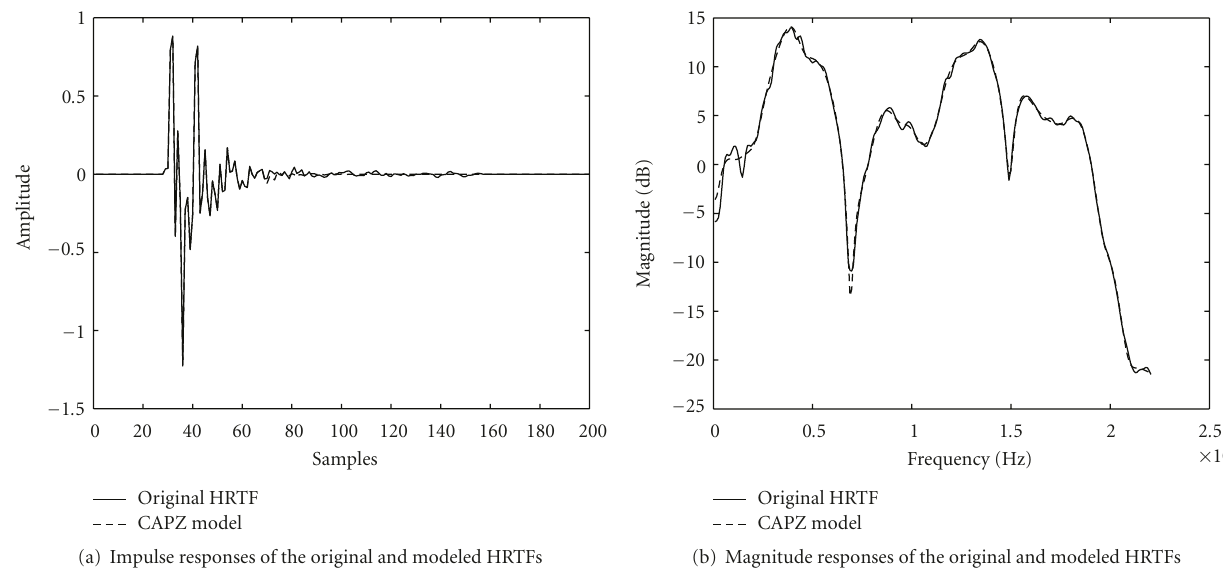
Figure 2: Comparison of the original and modeled right ear HRTF at elevation 0 ◦ , azimuth 30 ◦